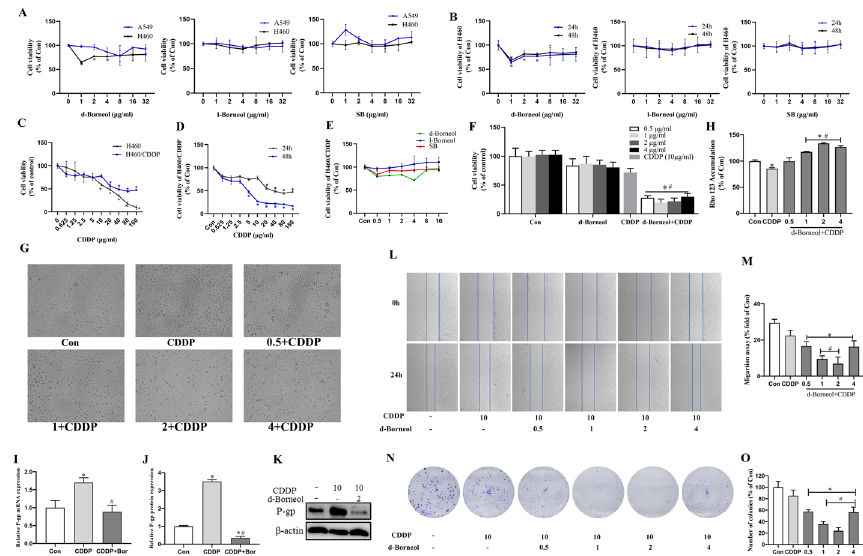
Fig. 1 Cell viability of different NSCLC cells treated with three borneol forms and cotreatment with d-borneol and CDDP, and effect on cell proliferation, P-gp function, and cell migration in H460/CDDP cells. A A549 and H460 cells cultured with different concentrations of d-borneol, l-borneol, and SB for 24 h; B H460 was treated with d-borneol, l-borneol, and SB for 24 h and 48 h, and cell viability was determined by MTT; C cell viability of H460 and H460/CDDP cells treated with diferent concentrations of CDDP for 24 h; D cell viability of CDDP on H460/CDDP cells for 24 h and 48 h; E cytotoxicity of the three borneol forms on H460/CDDP cells; F, G cell viability ( F ) and cell morphology ( G ) of H460/CDDP cells treated with CDDP (10 μg/ml), or d-borneol (0.5, 1, 2, and 4 μg/ml) CDDP (10 μg/ml) for 24 h; H determination of P-gp function after treatment with CDDP, CDDP + plus d-borneol with different concentrations for 24 h; I , K mRNA expression ( I ) and protein expression ( J , K ) of P-gp; L , M cell migration of H460/CDDP cells; N representative photographs showing colony formation after CDDP cotreatment with d-borneol in H460/CDDP cells; O calculation of statistical differences. All data are presented as mean SD (n 3, * P < 0.05, compared with Con; # P < 0.05, compared with CDDP ± =